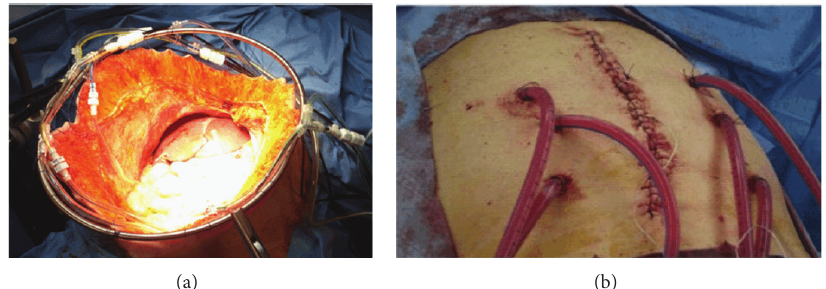
Figure 1: (a) The open (coliseum) technique. (b) The closed abdomen technique.